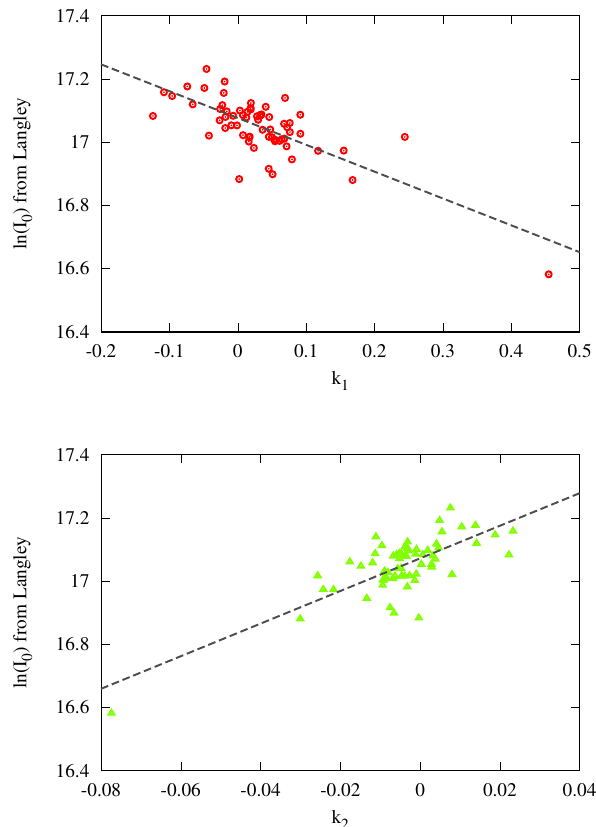
Figure 10. Influence of the AOD daily cycle on extraterrestrial cal- ibration constants retrieved by Langley plots (slit 3). k 1 and k 2 rep- resent the magnitude of the curvature of the daily variation as pa- rameterised in Eqs. (3) and (4). The dashed lines show the fit to the points. The correlation indexes of the retrieved ETC to k 1 and k 2 are − 0.75 and